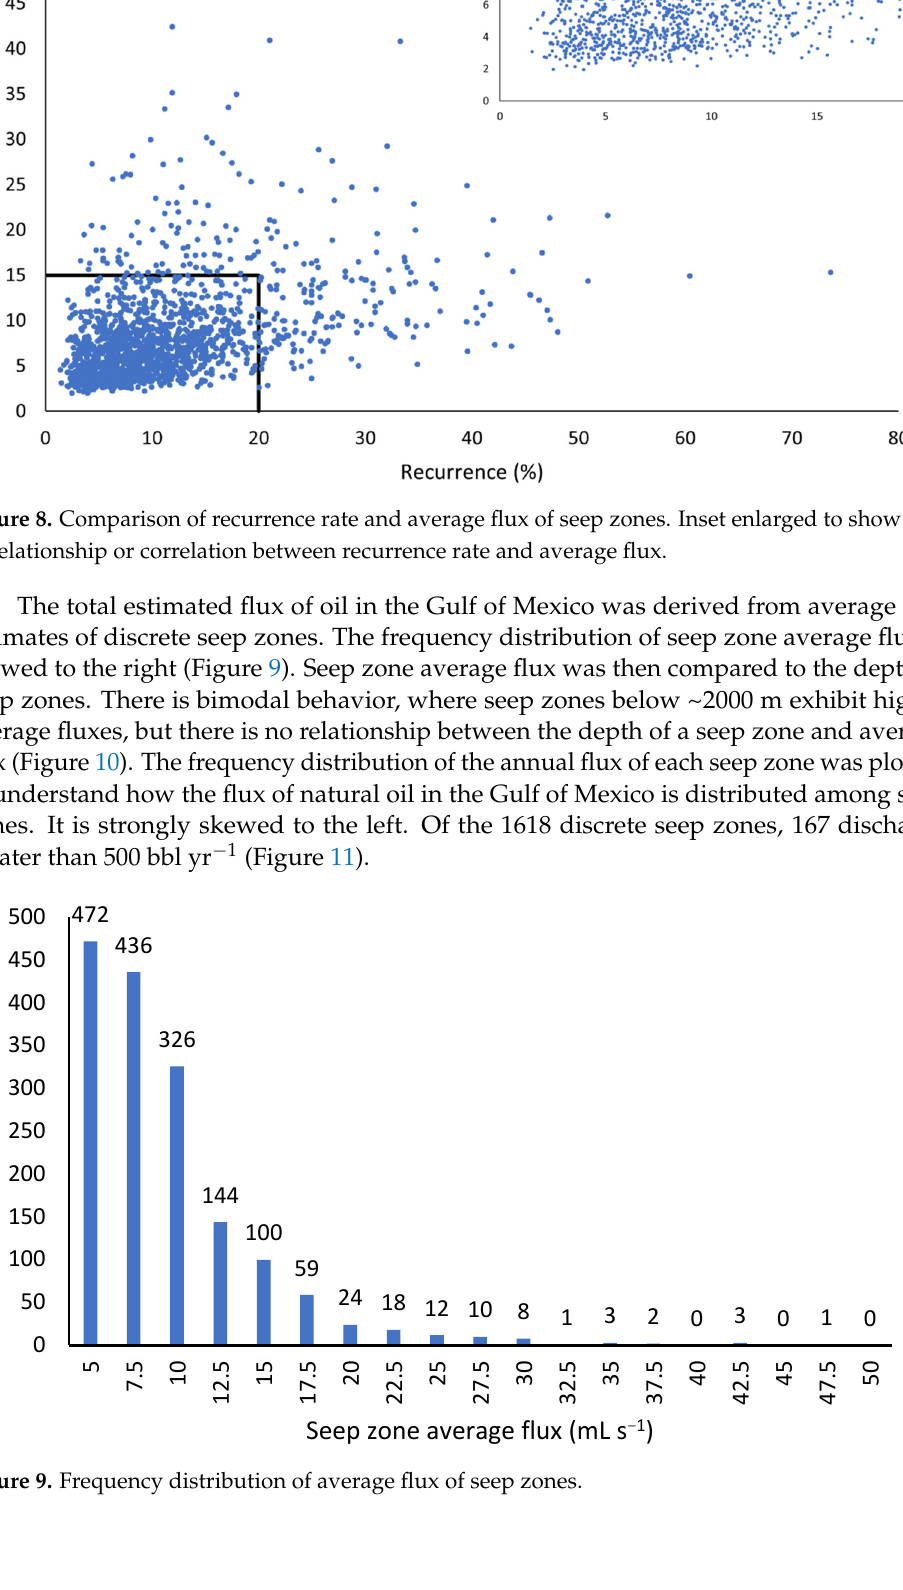
Figure 7. Frequency distribution of seep zone recurrence rates.